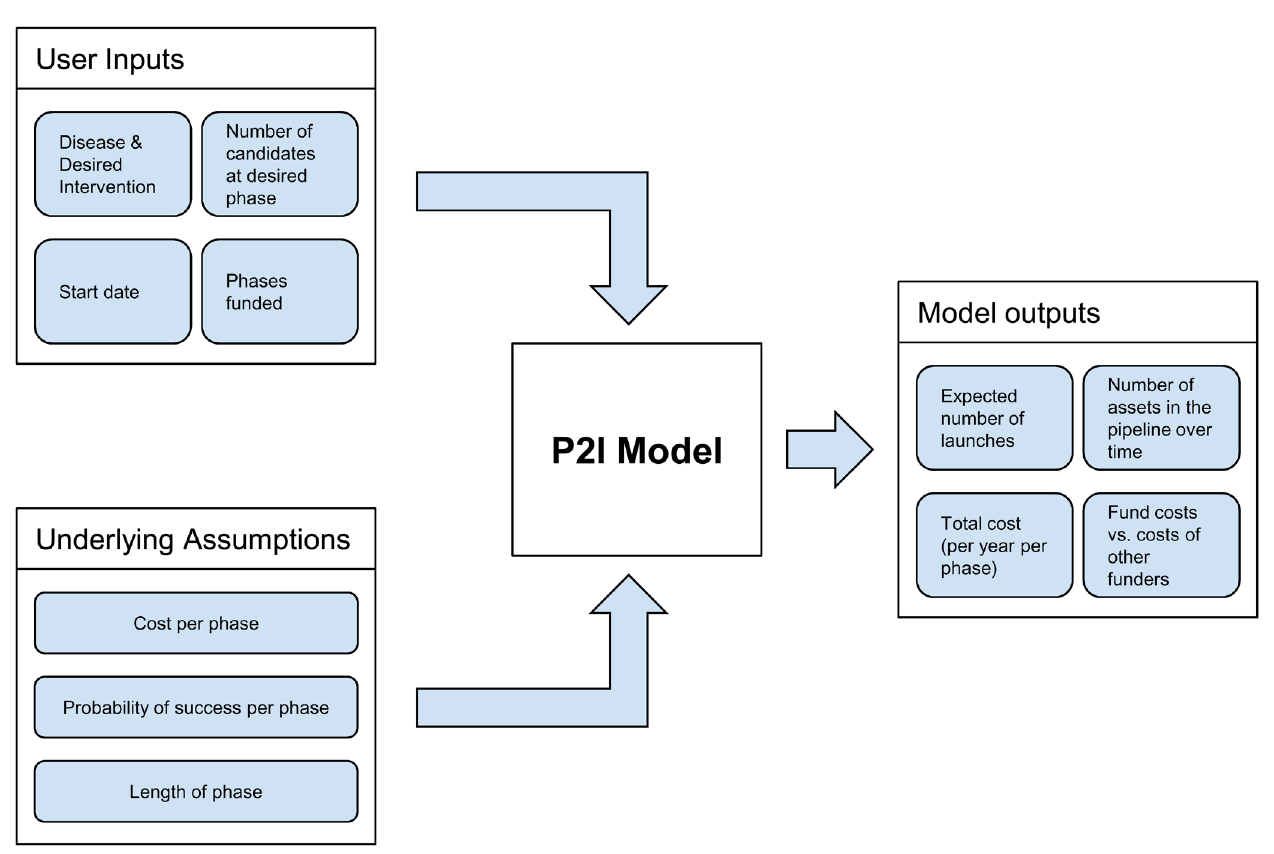
Figure 1. Conceptual overview of P2I